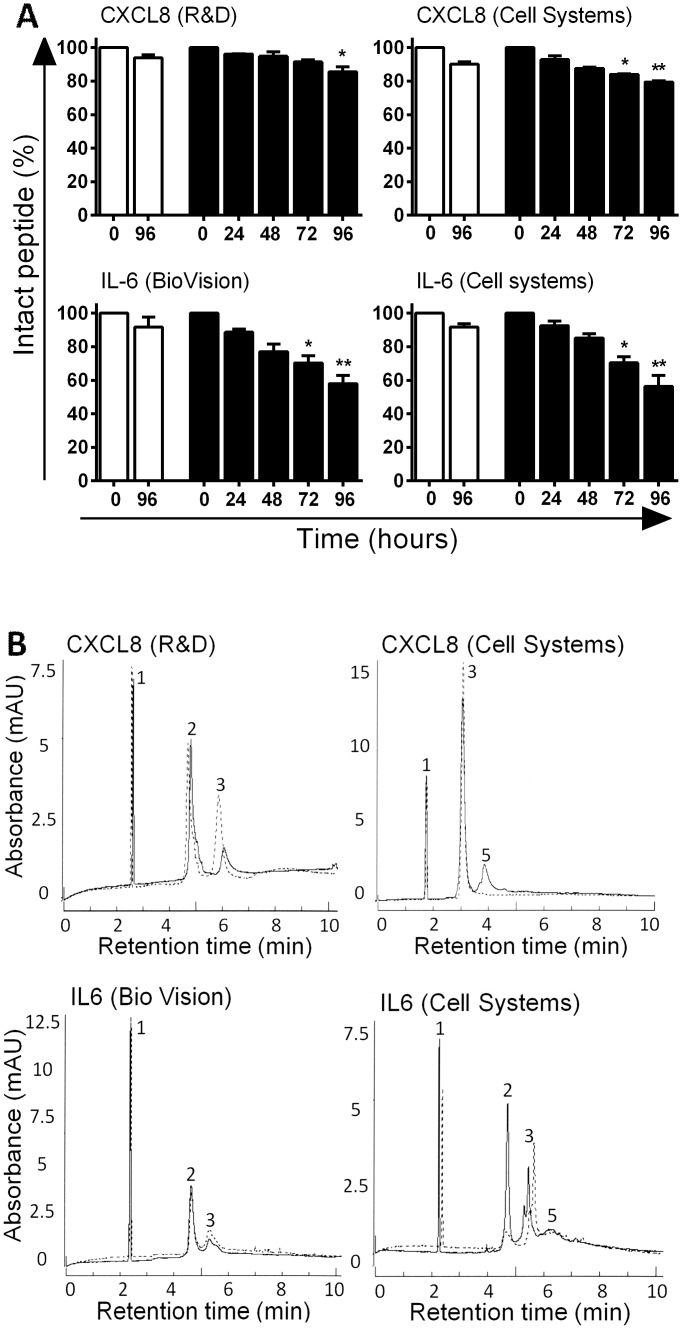
Stability of cytokines during incubation with chronic wound extract.A: Percentage of intact cytokines during incubation with CWE, relative to the cytokine amount at the start of incubation. White bars = incubation with PBS, black bars = incubation with CWE. Bars represent means ± SEM of three independent experiments, performed with CWE pools of 5 donors. * P <0.05, ** P <0.01. B: Capillary zone electrophoresis graph of cytokine incubation with CWE; dashed line = 0 h, solid line = 96 h. 1 = internal standard, 2 = CWE, 3 = Intact cytokine, 4 + 5 = degradation products.